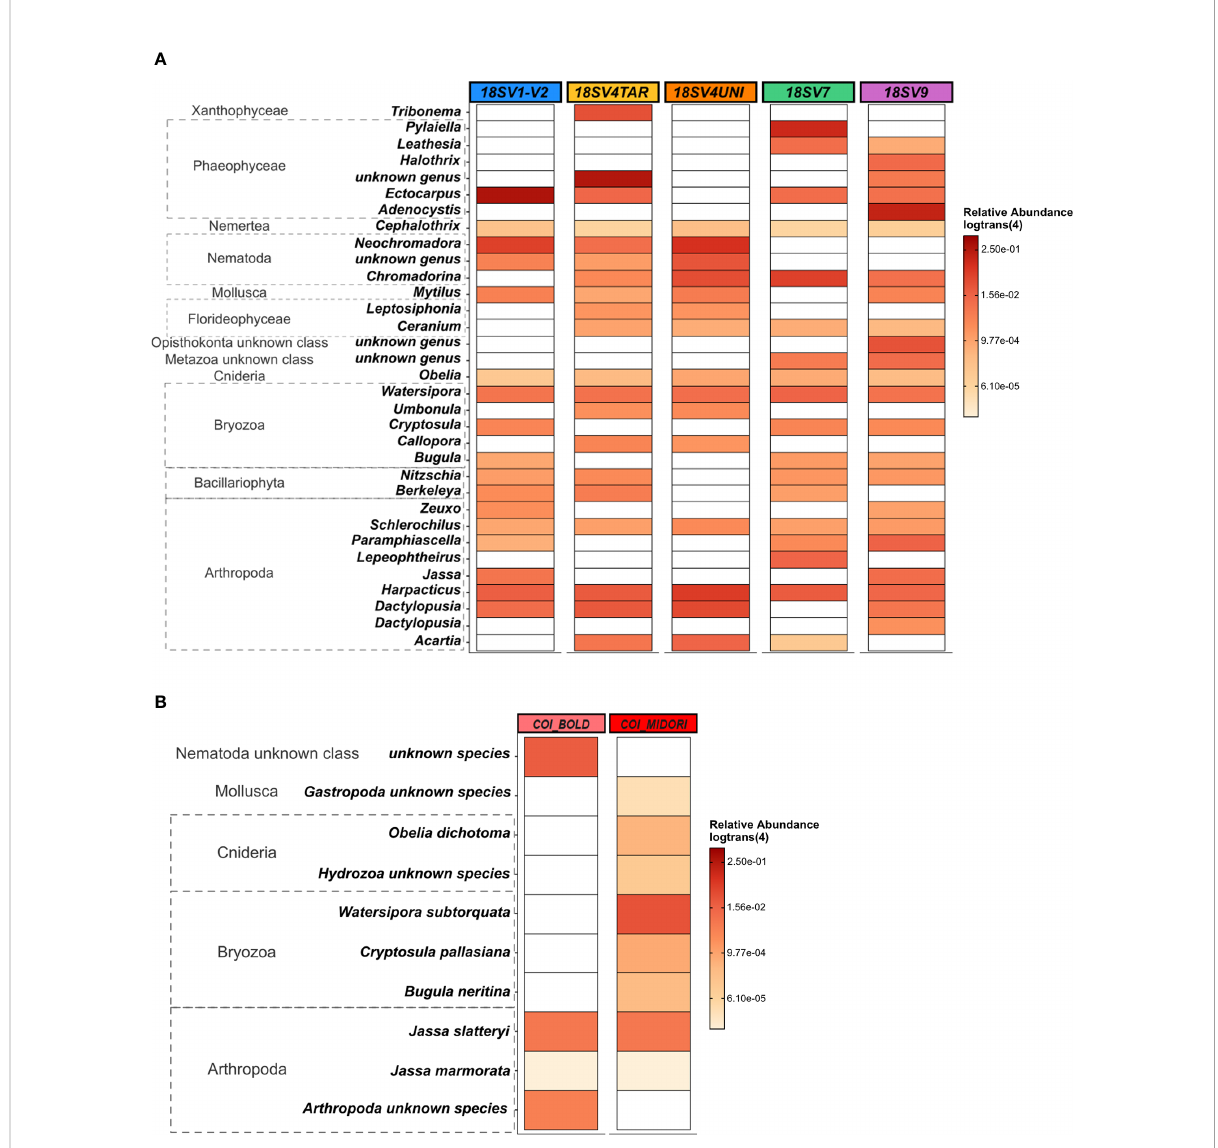
FIGURE 3 Heat map based on the relative abundance [in log_trans (4)] of: (A) the 33 most abundant eukaryote genera across fi ve hypervariable regions of 18S rDNA selected if > 0,5%. (B) The 10 most abundant eukaryote species across COI using two databases selected if > 0,1%. Samples used are the three panels (PVC, PA, and HDPE) from Toulon extracted with the PMS method and ampli fi ed with fi ve hypervariable regions of 18S rDNA (n = 45